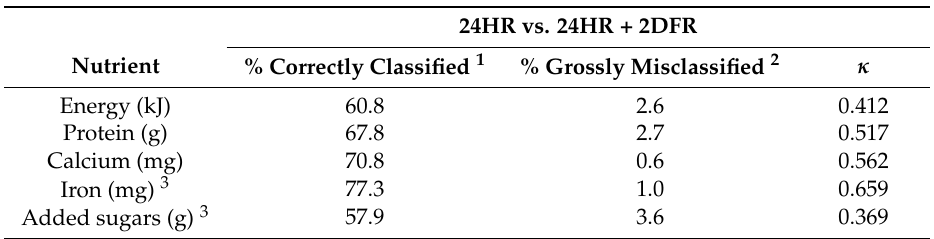
Table 3. Cross-classification for agreement between the 24HR and 24HR + 2DFR for average intake of nutrients and weighted Kappa statistic in Australian toddlers aged 12 months ( n =